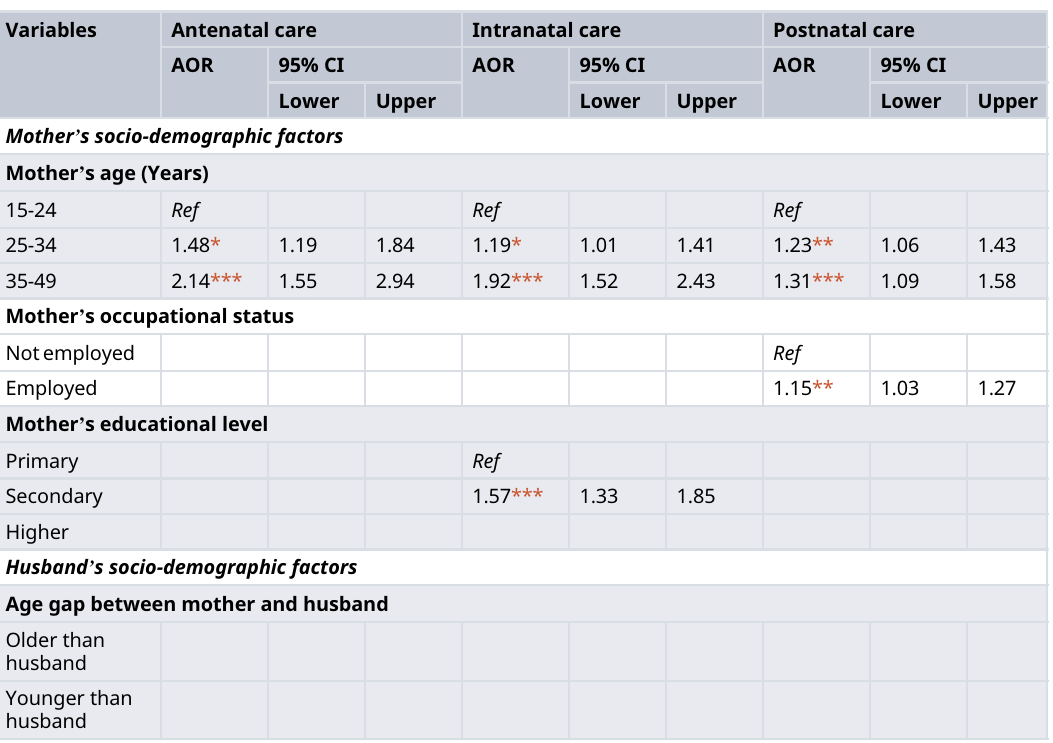
Table 2. Factors associated with maternal healthcare services